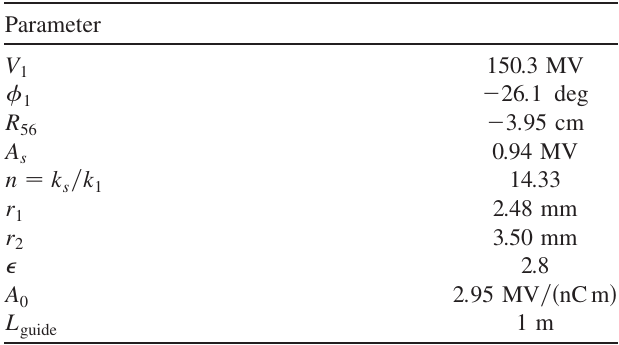
TABLE I. The rf and bunch compression parameters for the second-order compensation with the passive linearizer ( C ¼ 3 : 5 ).